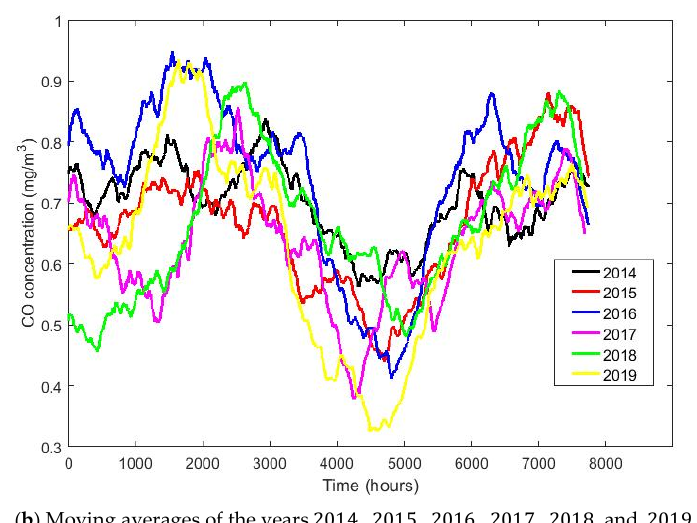
Figure 3. Moving averages of half of the years.